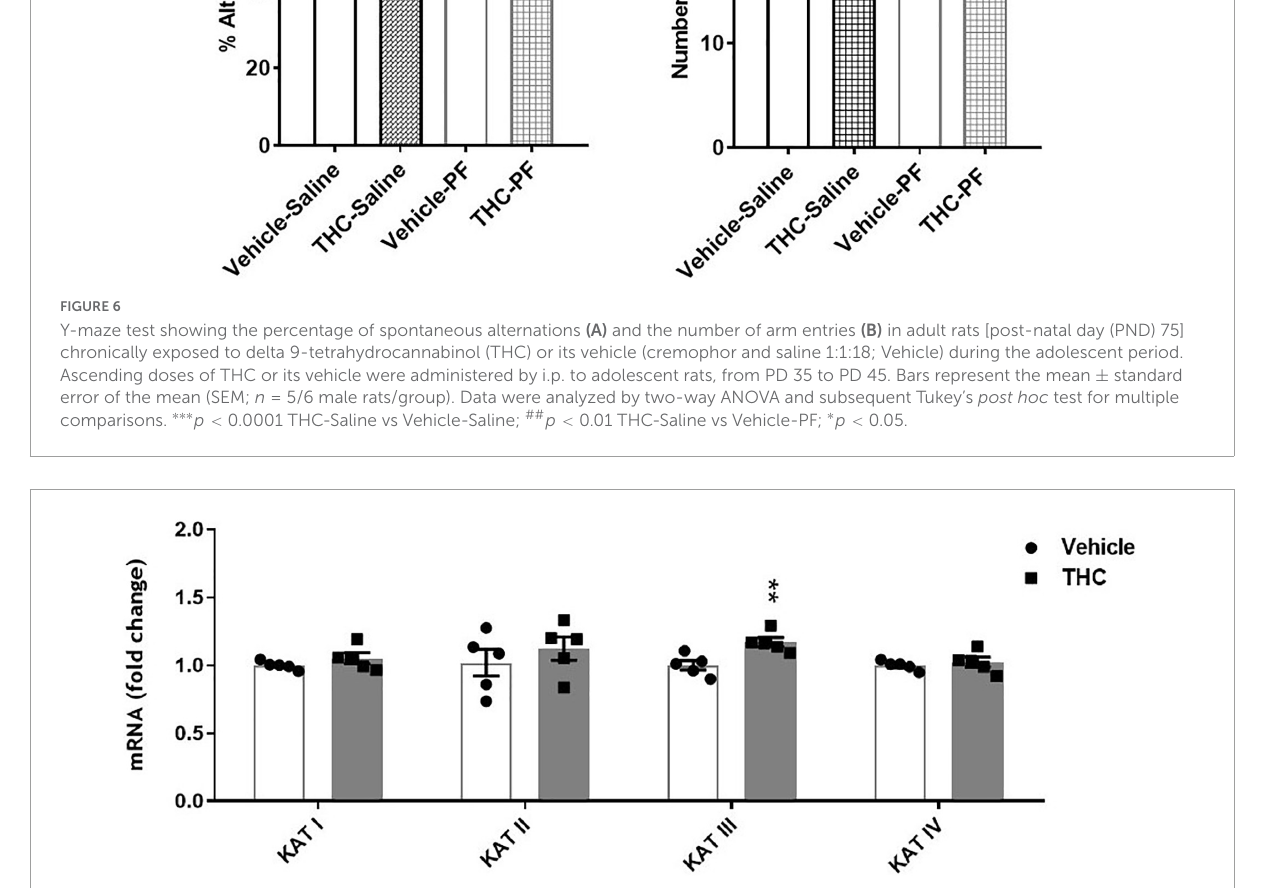
FIGURE7 Enzyme expression of kynurenine aminotransferases (KATs) isoforms in prefrontal cortex tissues from adult [post-natal day (PND) 75] rats chronically exposed to delta 9-tetrahydrocannabinol (THC) or its vehicle (cremophor and saline 1:1:18; Vehicle) during the adolescent period. Ascending doses of THC or its vehicle were administered by i.p. to adolescent rats, from PD 35 to PD 45. Bars represent the mean ± standard error of the mean (SEM; n = 5/group). Data were analyzed by Student’s t -test. ** p < 0.01 THC vs